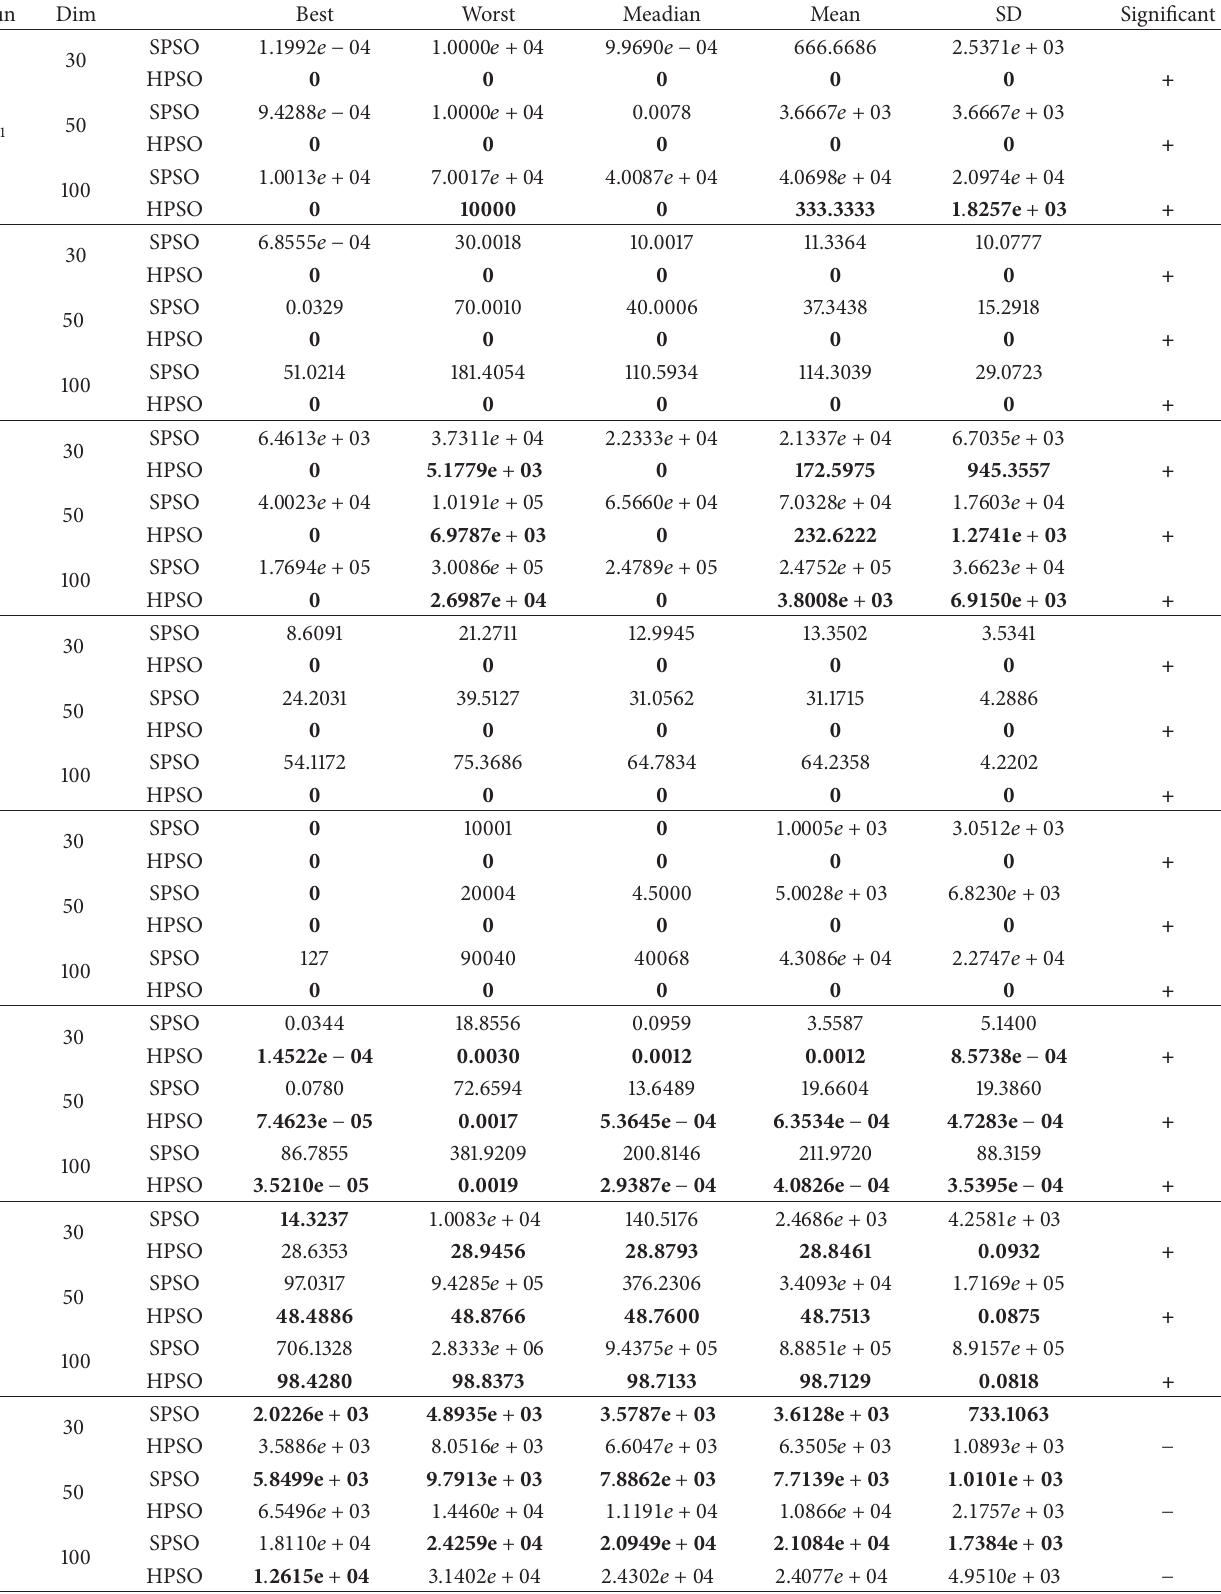
Table 2: Experimental results obtained by SPSO and HPSO on function from 𝐹 1 to 𝐹 10